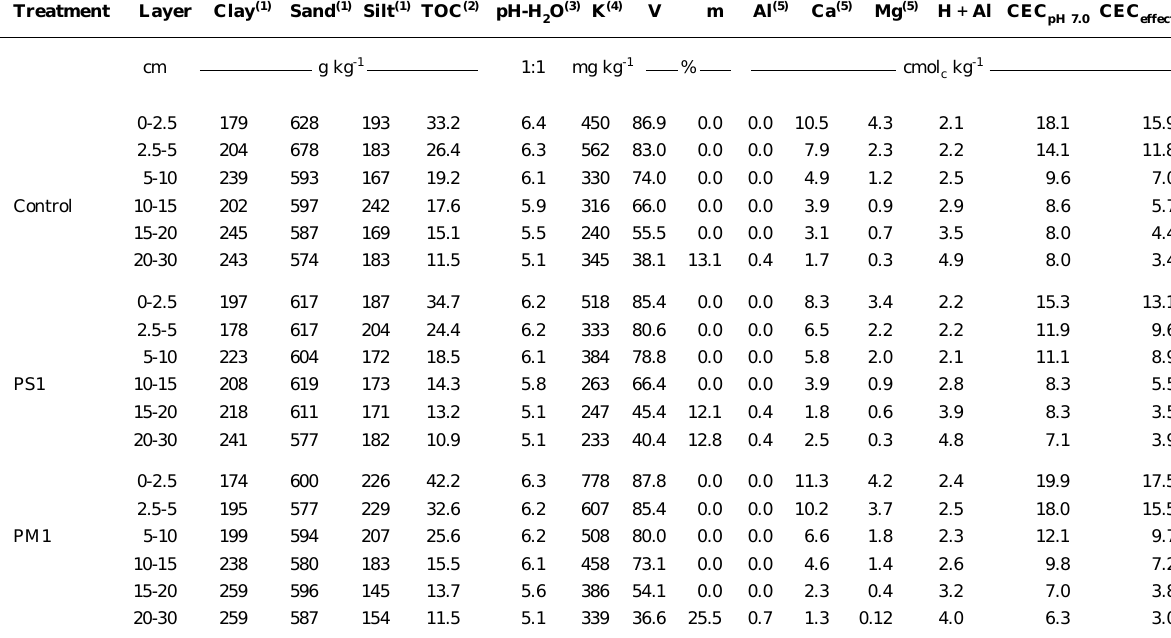
Table 1. Physical and chemical properties of a Typic Hapludult soil without pig litter, with the application of pig slurry (PS1) and of pig manure (PM1) in a no-till